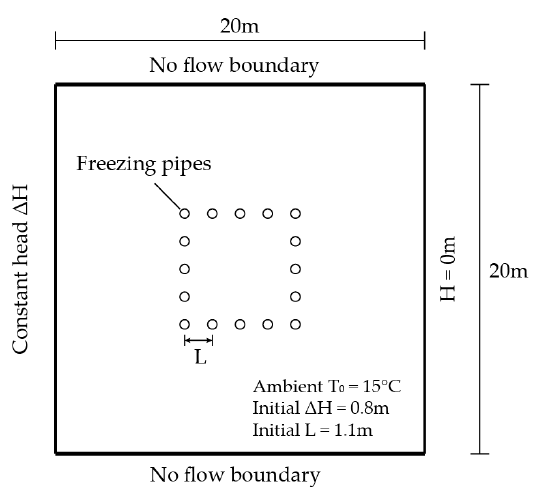
Figure 4. Model geometry, initial and boundary conditions for the simulation of the artificial ground freezing (AGF) project. Table 1. Parameters used in numerical experiments.